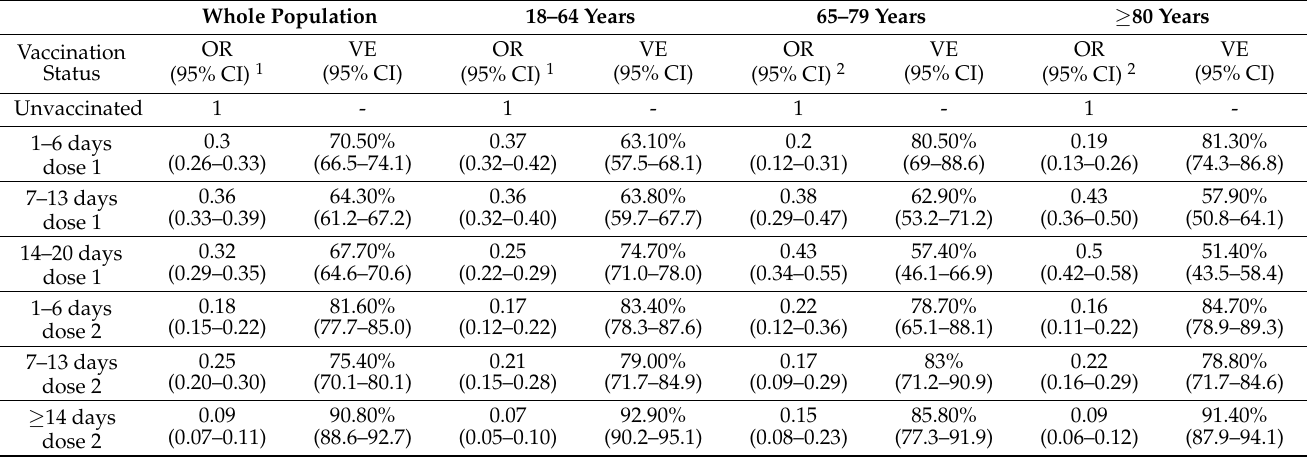
Table 2. BNT162b2 vaccine effectiveness in preventing SARS-CoV-2 infection stratified by age, time since vaccine administration and number of received doses.